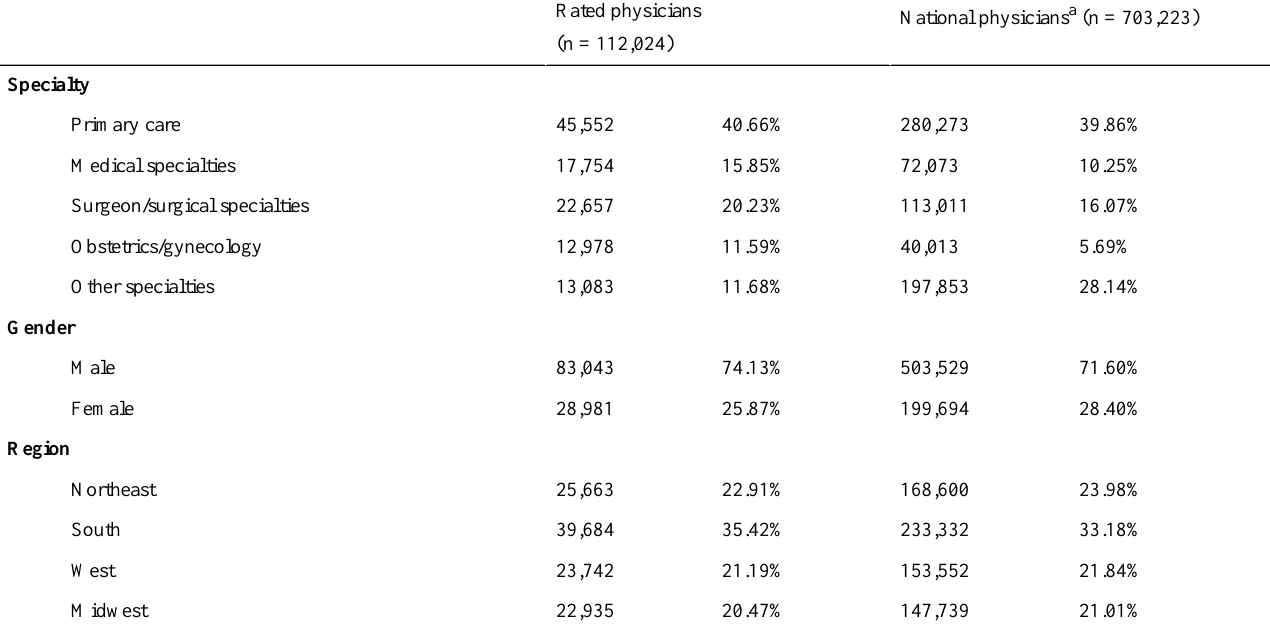
Table 1. Comparison of the physicians rated in RateMDs.com versus the national physician population.